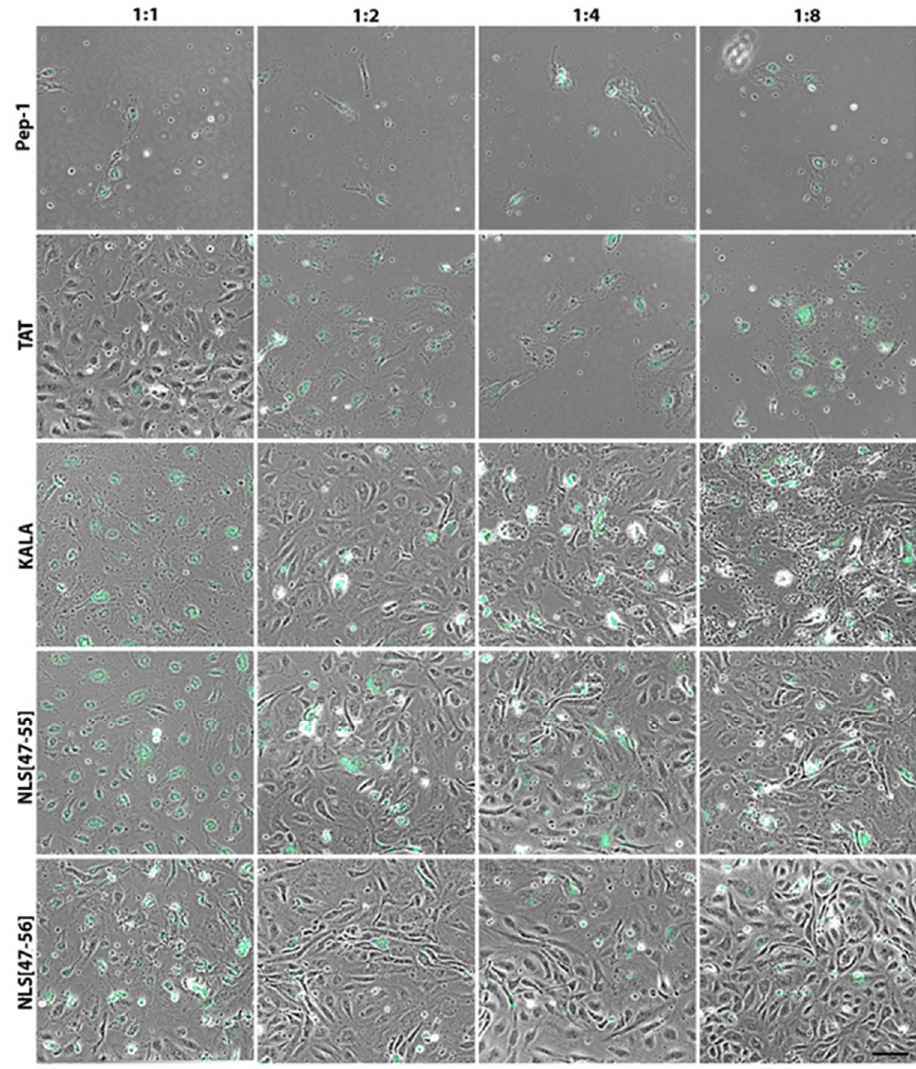
Figure 19. Effect of 48 h culture in the presence of complexes in CRs of 1:1, 1:2, 1:4 and 1:8. The complexes were formed using incubation of 2 μ g pmaxGFP with chosen CPPs at 21 °C for 30 min. CR, charge ratio. ( A ) Transfection efficiency. ( B ) Percent of cells with abnormal morphology. Data are presented as means, numbers in parentheses represent standard deviations.